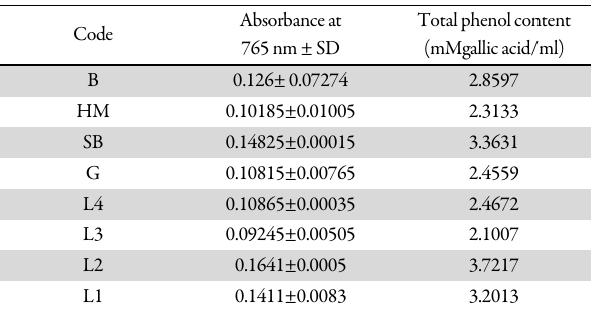
Table 4. Total phenol content of the studied lingonberry sample Eastern Carpathian provenience and from different habitat types (L 1, 2,